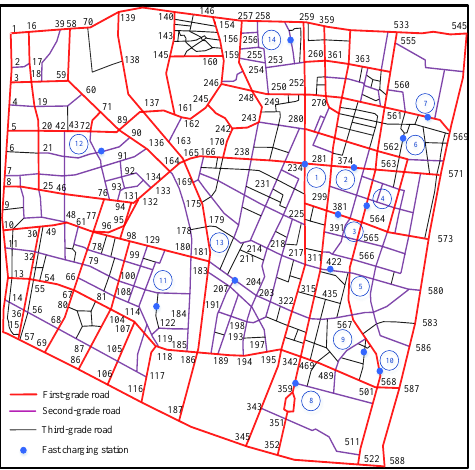
Figure 4. Topological structure of traffic network and distribution of fast-charging stations.